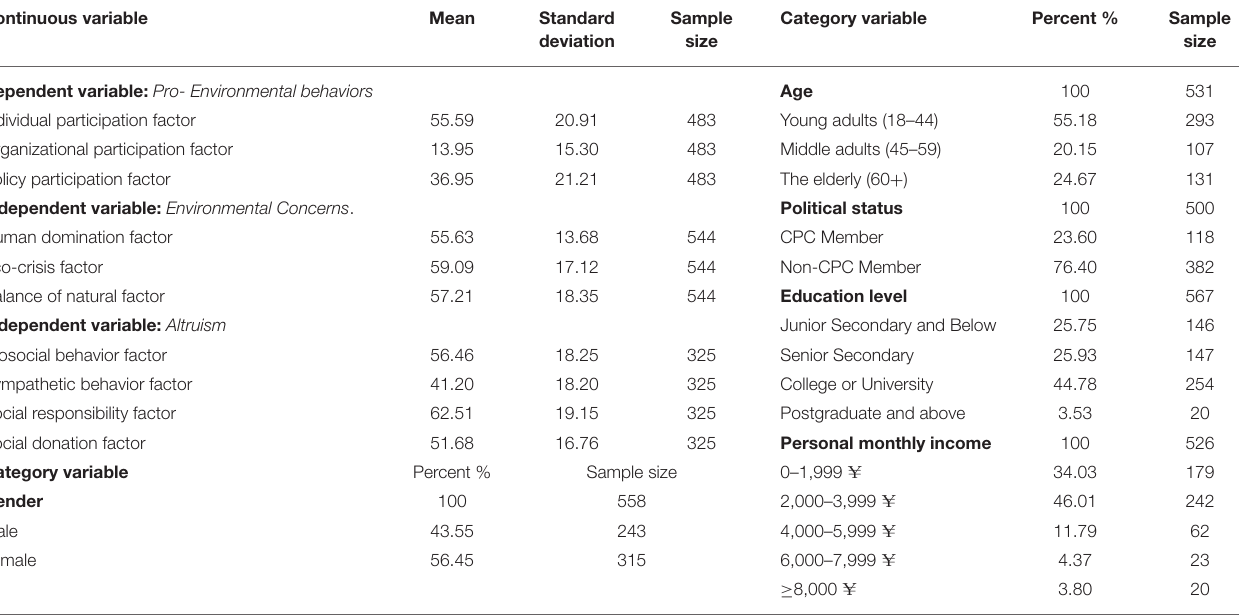
TABLE 2 | Descriptive statistics of research